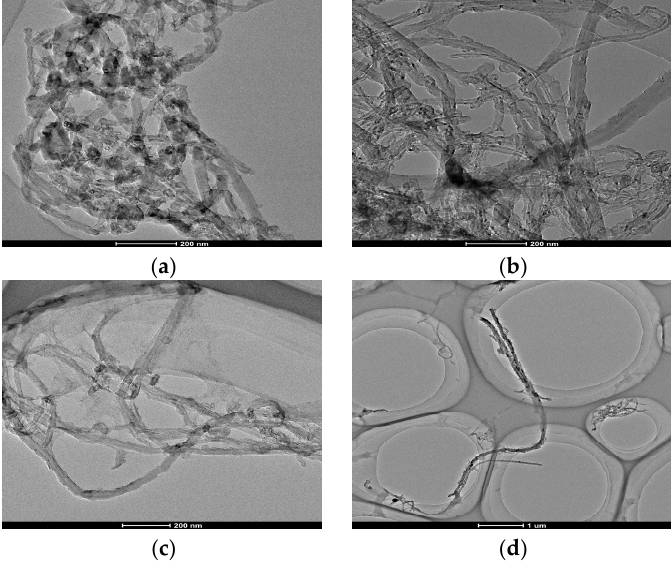
Figure 4. CNT dispersion. ( a ) without Ce(SO 4 ) 2 , ( b ) 0.3 wt.% Ce(SO4) 2 , ( c ) 0.6 wt.% Ce(SO 4 ) 2 , ( d ) 0.6 wt.% Ce(SO 4 ) 2 (single).